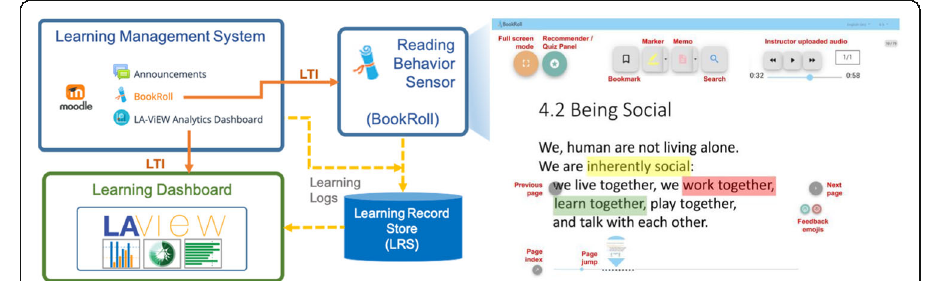
Fig. 1 Learning Evidence Analytics Framework and BookRoll reading